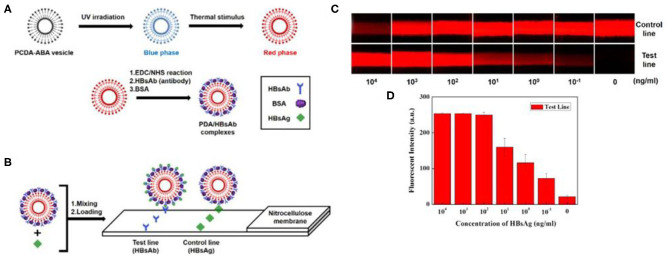
Schematic illustration of HBsAg detection on the NC membrane using red PDA/HBsAb complexes. (A) Schematic illustration of the structural design of PDA/HBsAb complexes for HBsAg detection. (B) Representative picture showing the detection of HBsAg on the NC membrane using red HBsAg- PDA/HBsAb complexes. Detection of HBsAg using PDA/HBsAb complexes. (C) Fluorescent image of the NC membrane (exposure time:1/3.5 s) and (D) fluorescent quantitative analysis of the test line. Reprinted with permission from Roh et al. (2017). Copyright 2017, Wiley.